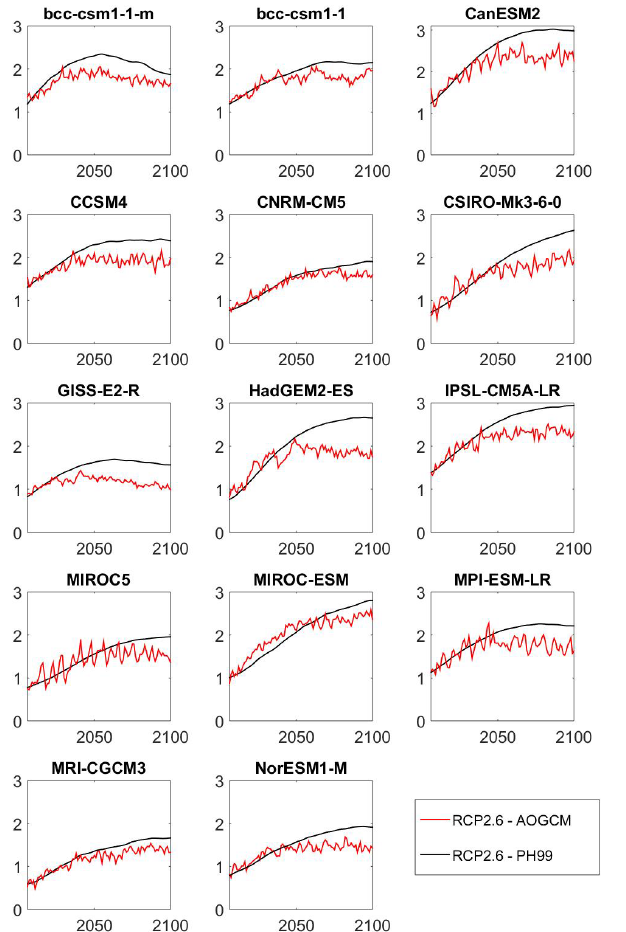
Figure 1. Comparison of temperature paths (K) projected by PH99 (black curve), calibrated by an AOGCM’s ECS and TCR, to the corresponding AOGCM’s temperature paths (red curve). Deviations on the order of 0.5K for 2100 are